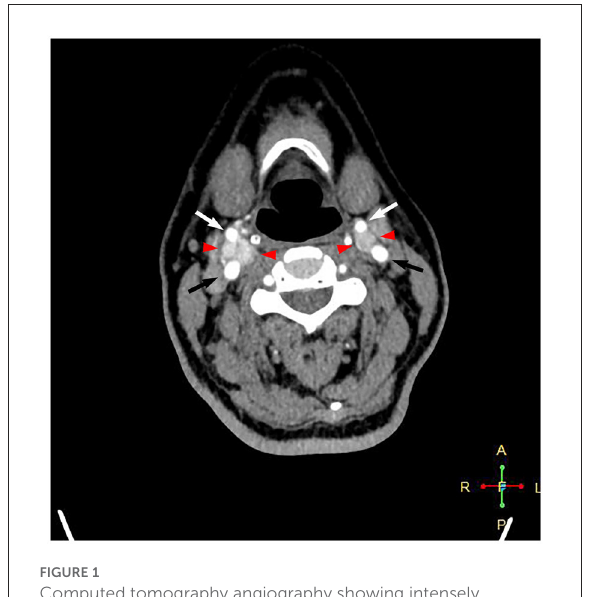
FIGURE1 Computed tomography angiography showing intensely enhanced masses at the level of bilateral carotid bifurcations. Black arrows point to the internal carotid artery, white arrows point to the external carotid artery, and red arrowheads point to the carotid body